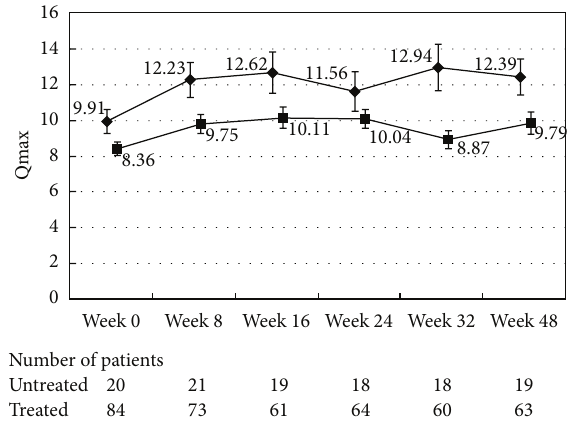
Figure 6: Maximal urinary flow rate. The scores in the patients treated with an 𝛼 1-blocker or anticholinergic agent ( ◼ ) and the untreated patients ( ⧫ ) are shown. The values are LS mean ± SE. 𝑃 = 0.1170 (repeated ANOVA).